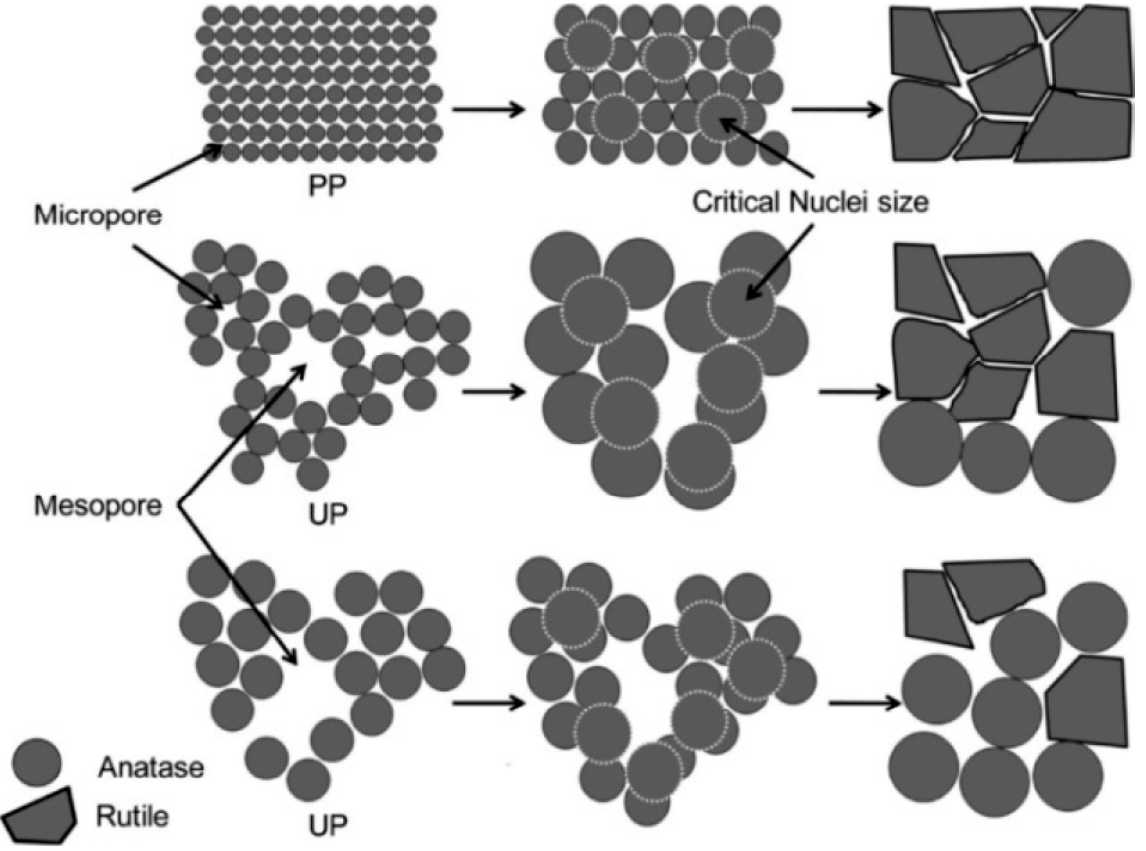
Fig. 2. Influence of peptization on the anatase to rutile phase transformation, reprinted with permission from S. Winardi, R.R. Mukti, K.N.P. Kumar, J. Wang, W. Wunderlich and T. Okubo // Langmuir. 26 (2010) 4567, (c) 2010 American Chemical